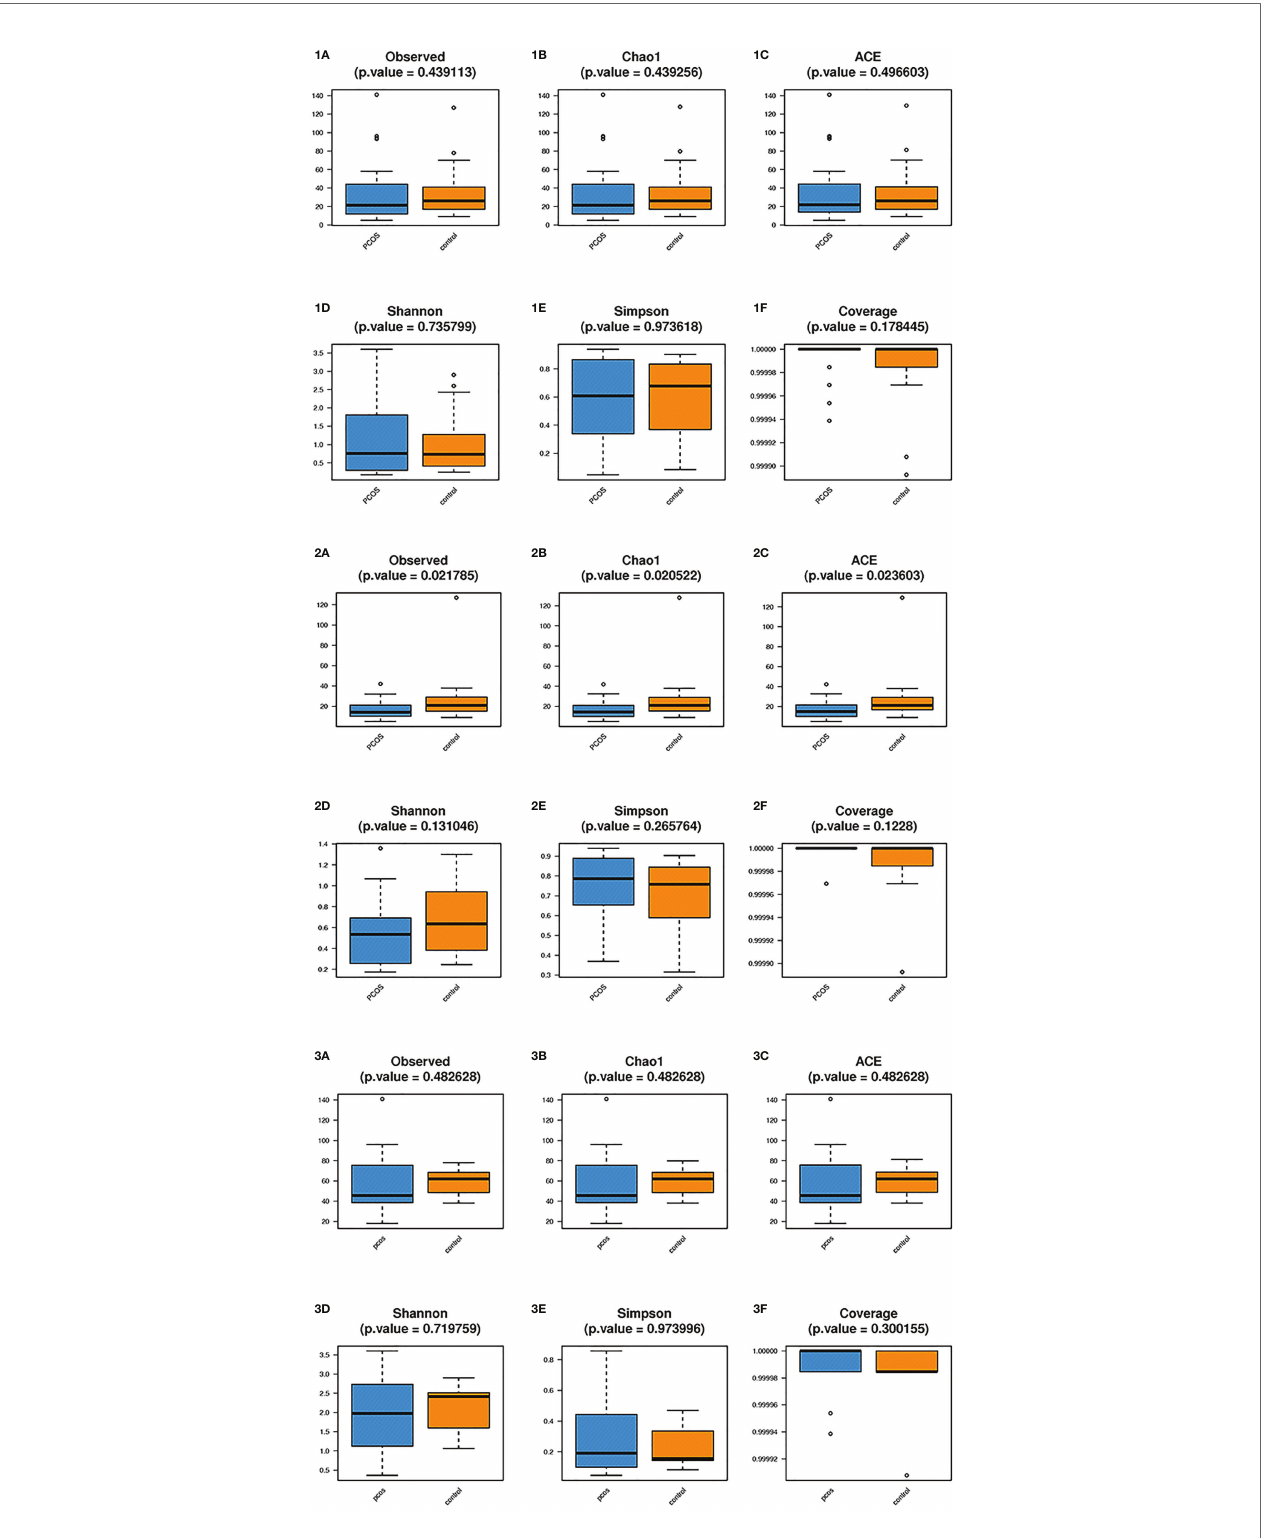
FIGURE 3 | Alpha diversity analyzes between the total polycystic ovary syndrome (PCOS) and total control groups, L-PCOS and L-control groups, N-PCOS and N- control groups. Alpha diversity analyzes between the total PCOS and total control groups (1A – F) ; between the L-PCOS and L-control groups: (2A – F) ; and between the N-PCOS and N-control groups (3A – F)